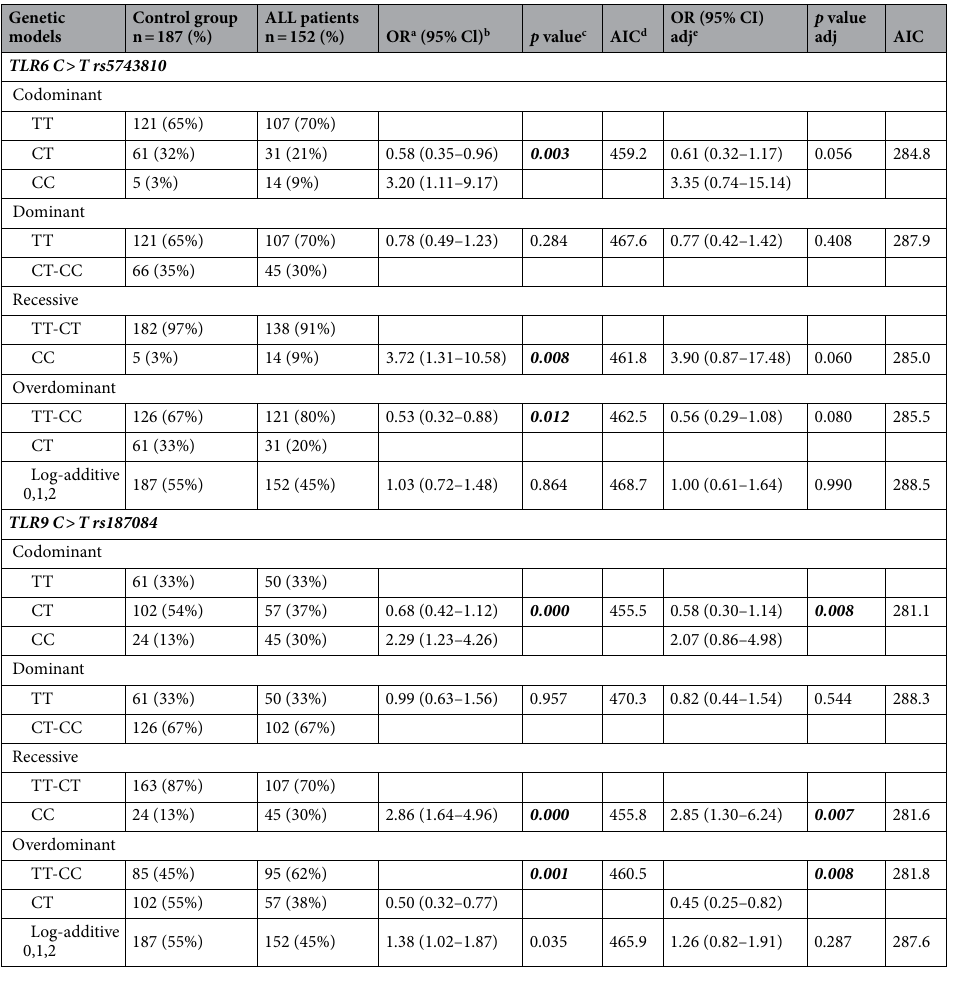
Table 2. Analysis of the association TLR6 C > T rs5743810 and TLR9 C > T rs187084 with the risk of acute lymphoblastic leukemia. a OR: Odds Ratio; b 95% confidence interval; c p value: < 0.05; d AIC: Akaike information criterion value; e Adj: Adjusted for sex and